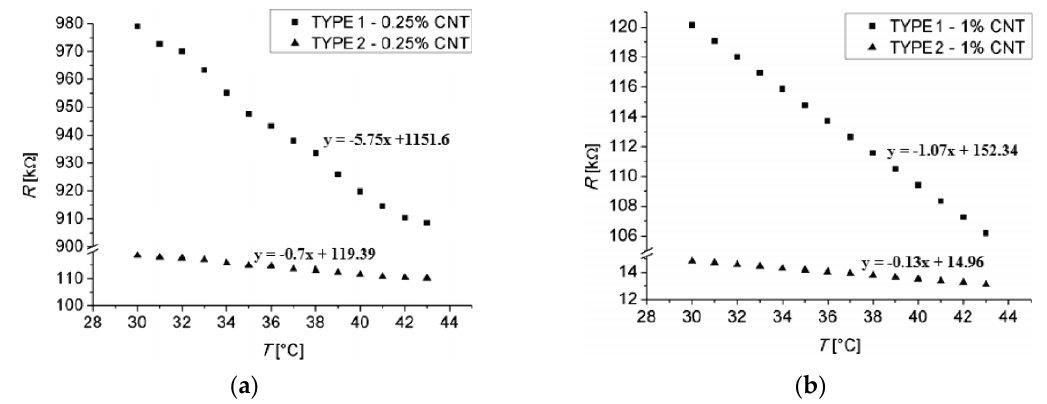
Figure 9. Temperature–resistance curve of sensors with ( a ) 0.25 wt % CNT and ( b ) 1 wt % CNT [35]. Thin films were also obtained by vacuum filtration over a support membrane of a solution containing CNTs [51,52]. Thus, 0.5 g of high purity MWCNT ( > 97%) was uniformly dispersed by sonication in 100 g of water containing 0.1 mg of sodium dodecyl sulfate. This solution is filtered by vacuuming through a membrane, resulting in a thin film of MWCNT (freestanding), stable, not supported by another structure, or by applying a chemical agent to bind CNTs. The thickness and density of this film can be controlled by the amount of filtered solution, and then, after drying, it can be cut to the desired shape on which metal electrodes can be built. Thus, di Bartolomeo [51] has obtained a sensor 3 x 6 mm in size and with a thickness of approx. 300 µ m, on the surface of which four electrodes were drawn from Ag with a distance of 1–2 mm between them (Figure